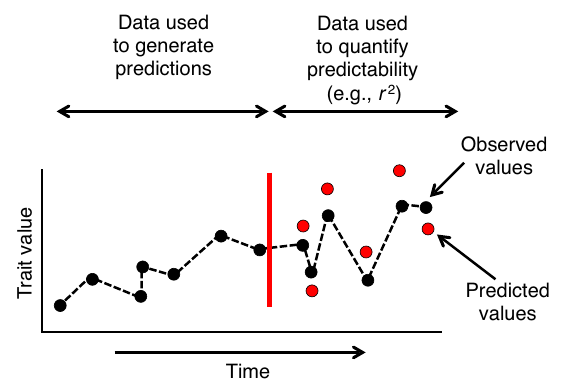
Fig. 1 Quantifying the predictability of short-term evolution using time- series data. Autoregressive moving average (ARMA) models can be applied to existing data to generate predictions for future trait values or allele frequencies. In turn, the fi t (e.g., r 2 value) of these predicted values to those actually observed provides a metric of the predictability of evolution.